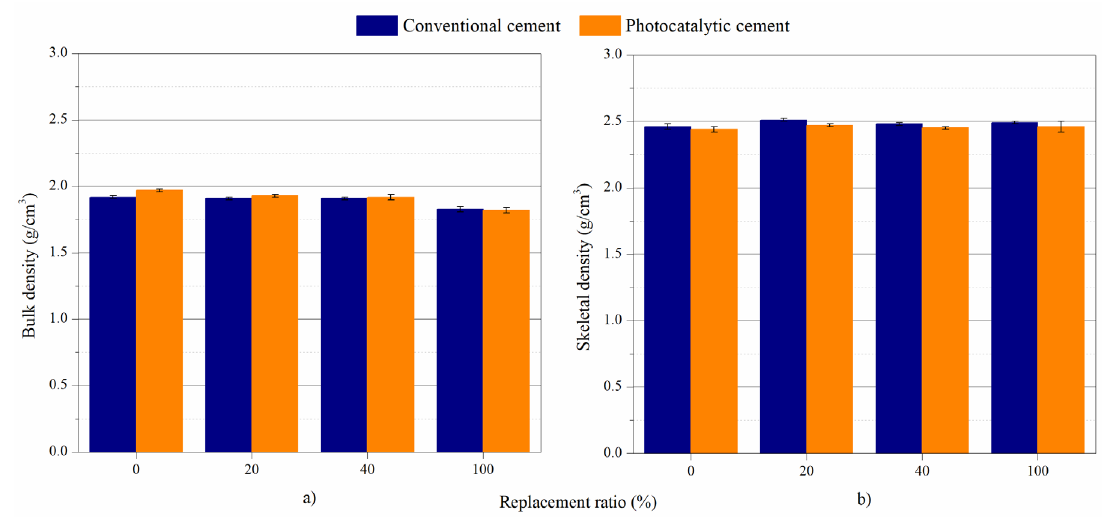
Figure 7. Comparison of results of ( a ) bulk density and ( b ) skeletal density.